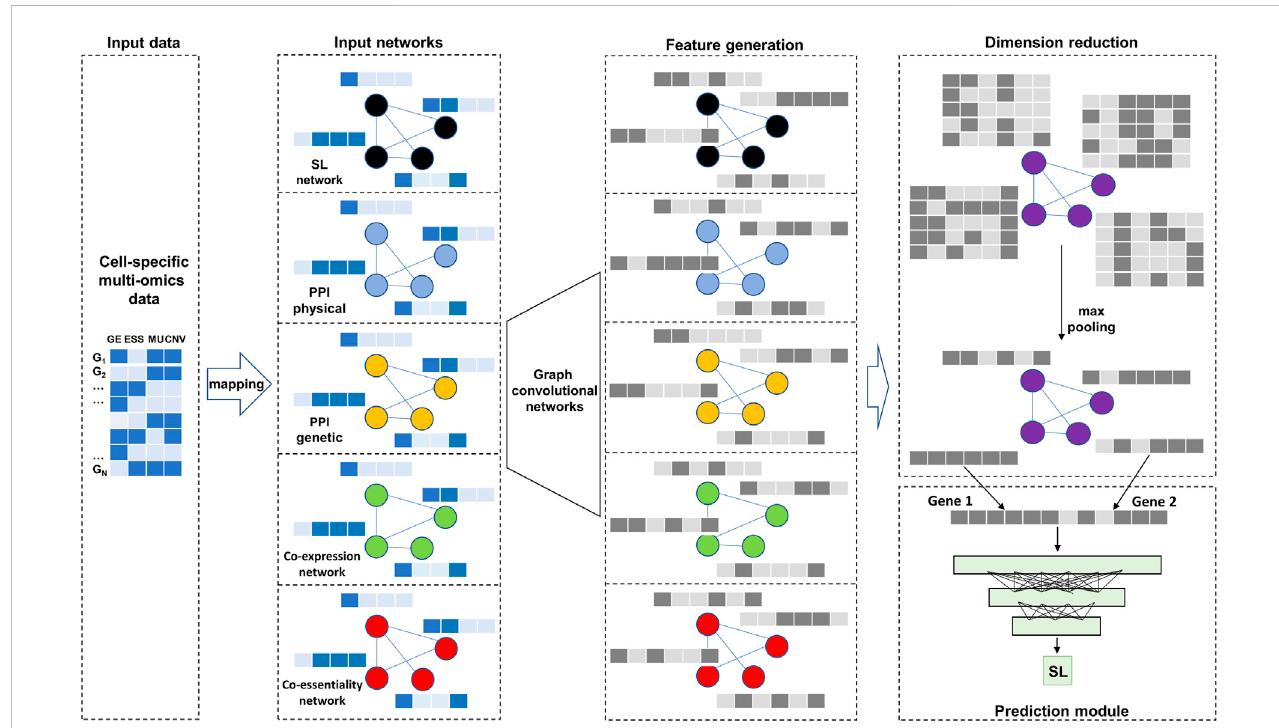
FIGURE 1 Overall model architecture. There are two types of input data: cell-speci fi c multi-omics data as node features and fi ve biological networks. After two layers of Graph convolutional networks and max pooling operation, the generated embeddings are used as input to a deep neural network for predicting SL.